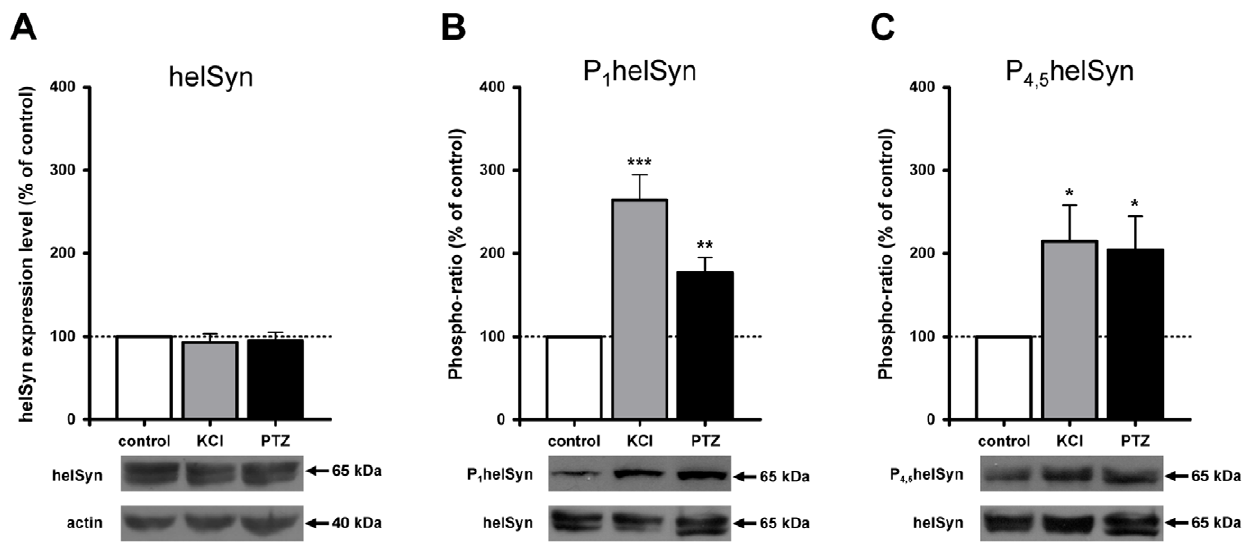
Figure 6. PTZ treatment increases synapsin phosphorylation of both domain A and B in Helix ganglia. (A) Western blot analysis of helSyn expression level normalized to actin along with histograms presenting average densitometric values. Values were similar in all experimental groups. (B,C) Mean density value of phospho-helSyn compared to that of total helSyn (phospho-ratio). Both phospho-site levels were increased by KCl or PTZ application.